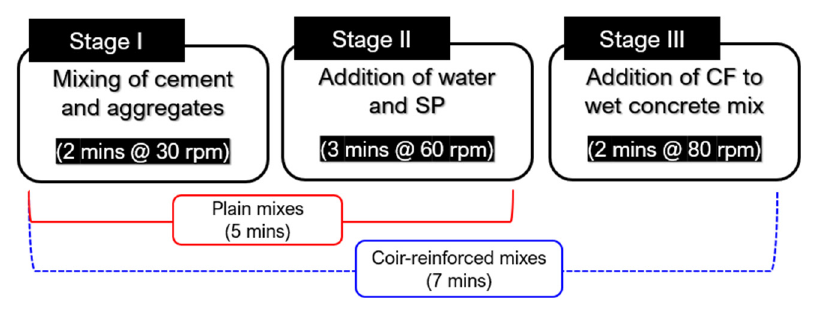
Figure 4. Mixing sequence for the preparation of concrete mixes.